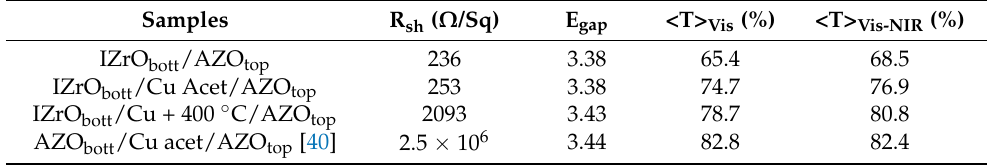
Table 3. Comparison of sheet resistance, energy band gap, mean value T in visible (400–800 nm) and visible–NIR (400–1100 nm) ranges of the best selected structures. Glass/IZrO bott /AZO top is reported as a reference point. The data for the AZO bott /Cu acetone/AZO top sample are from our previous work